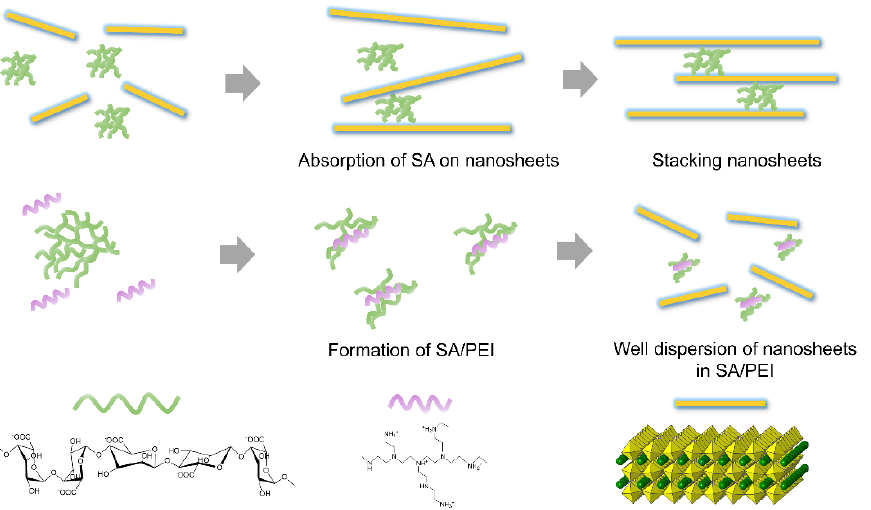
Figure 2. Schematic illustration of the adsorption of negatively charged SA on negatively charged CNO nanosheets and the formation of SA/PEI.